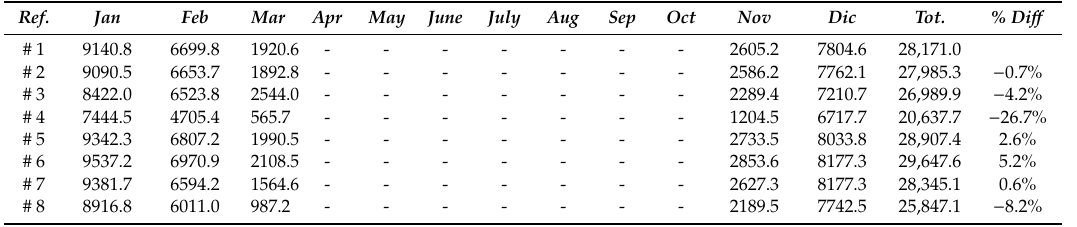
Table 3. Monthly thermal energy requirement (kWh / month) for heating, covered by the traditional generator for the di ff erent scenarios.